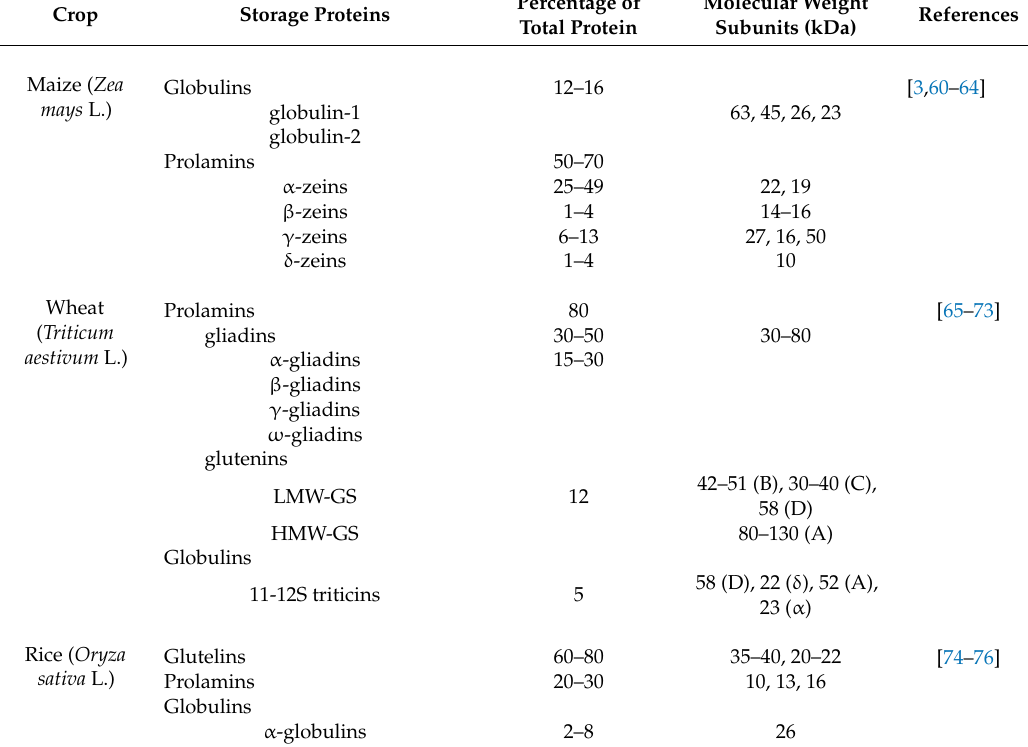
Table 1. List of seed and vegetative storage proteins in different crop